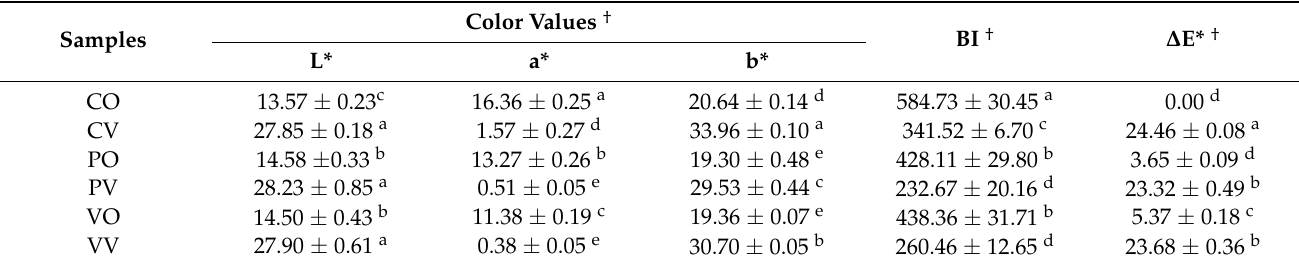
Figure 2. Photographs taken of date syrups prepared from juice extracted without enzyme (CO, CV) and with the aid of Pectinex (PO, PV) or Viscozyme (VO, VV) followed by evaporation using open heating (CO, PO, VO) or vacuum evaporation (CV, PV, VV). Table 1. Physicochemical properties of date syrups prepared using different extraction and evaporation methods.